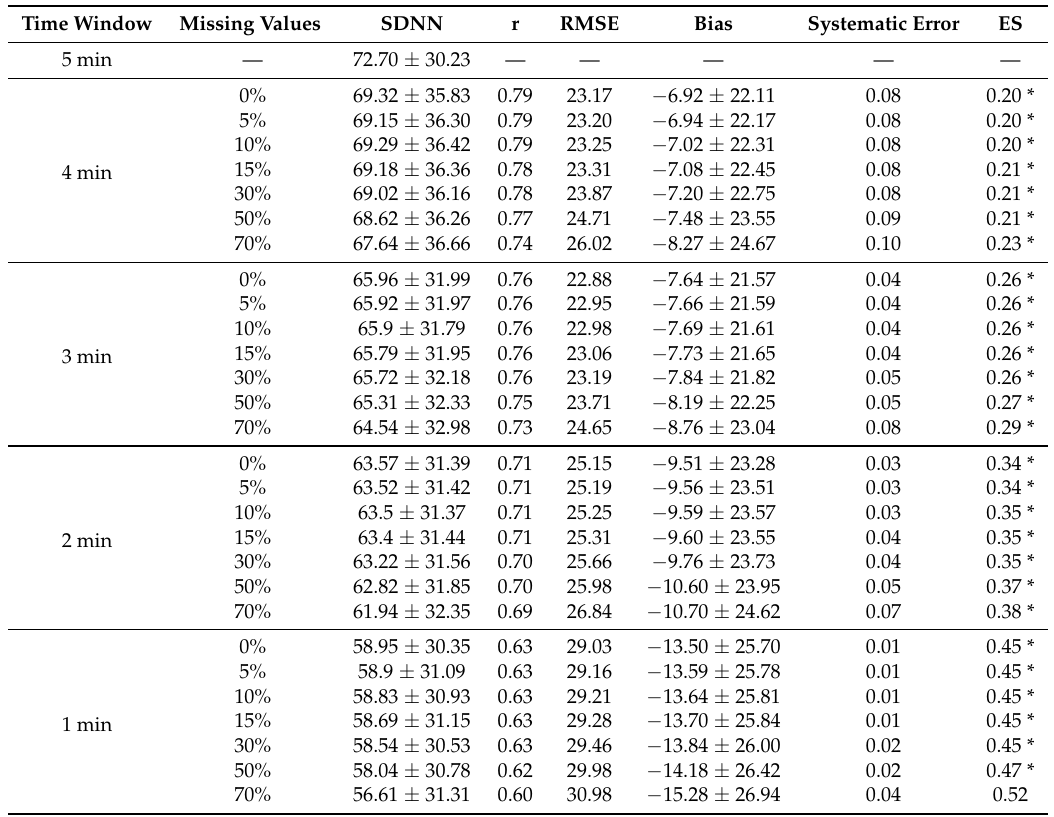
Table 1. Descriptive statistics and statistical analysis of SDNN for all of the time window and missing values. The statistical analysis is focused to compare 5 min HRV parameters to ultra-short ones. * refers to small ES of ultra-short HRV features compared to 5 min ones, respectively. r, RMSE, and ES refer to the correlation, the Root Mean Square Error, and the effect size between the ‘gold standard’ and the ultra-short with and without missing values on SDNN, respectively. Bias refers to mean ± standard deviation of the difference of ultra-short HRV parameters compared to ‘gold standard’ HRV parameters (i.e., 5 min time window), while systematic error is the Pearson’s correlation coefficient between means and differences between 5 min and ultra-short HRV